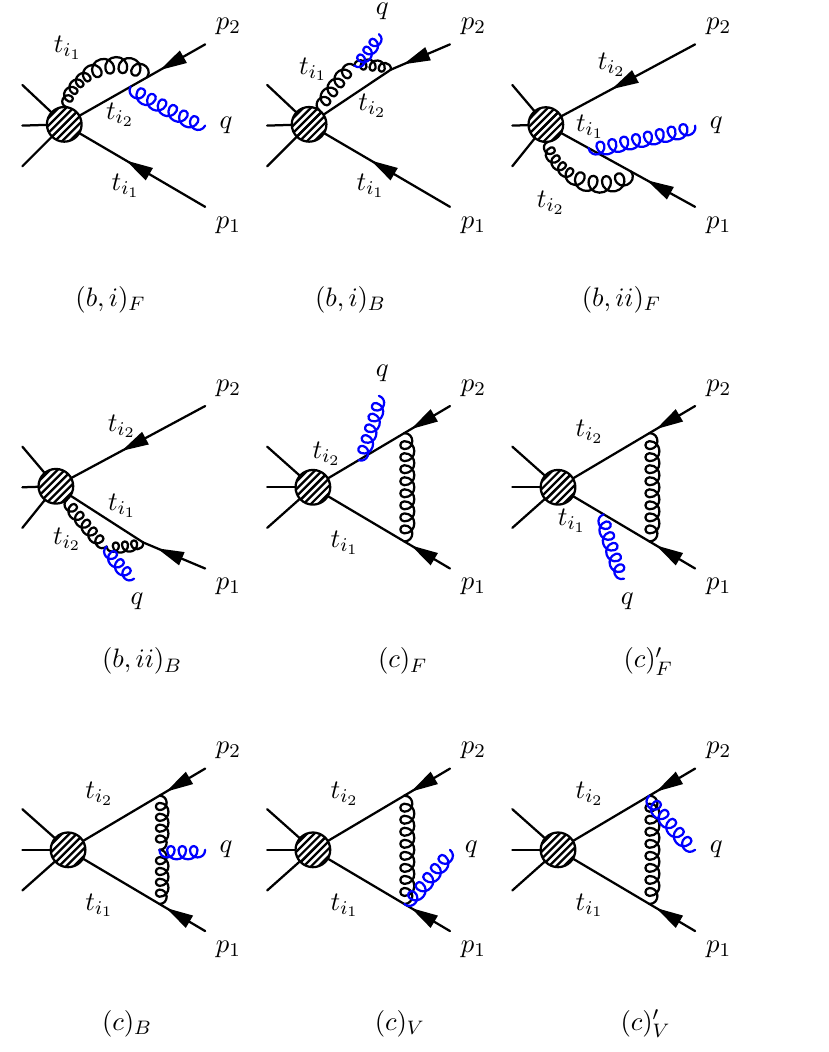
Figure 3 . Collinear loops contributing to the anomalous dimension δZ c,i mixing of B- into C-type operators. Arrows show the fermion flow for two outgoing antiquarks.